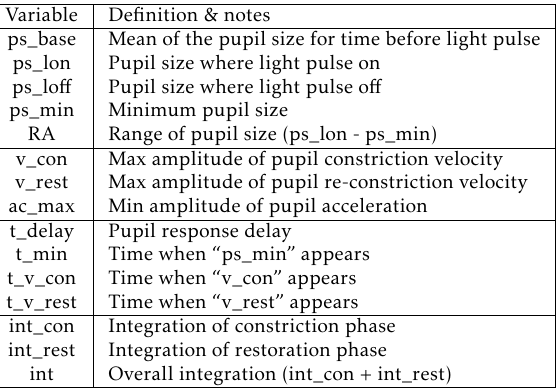
Figure 4. Feature extraction from PLR responses Table 2. Definitions of PLR features